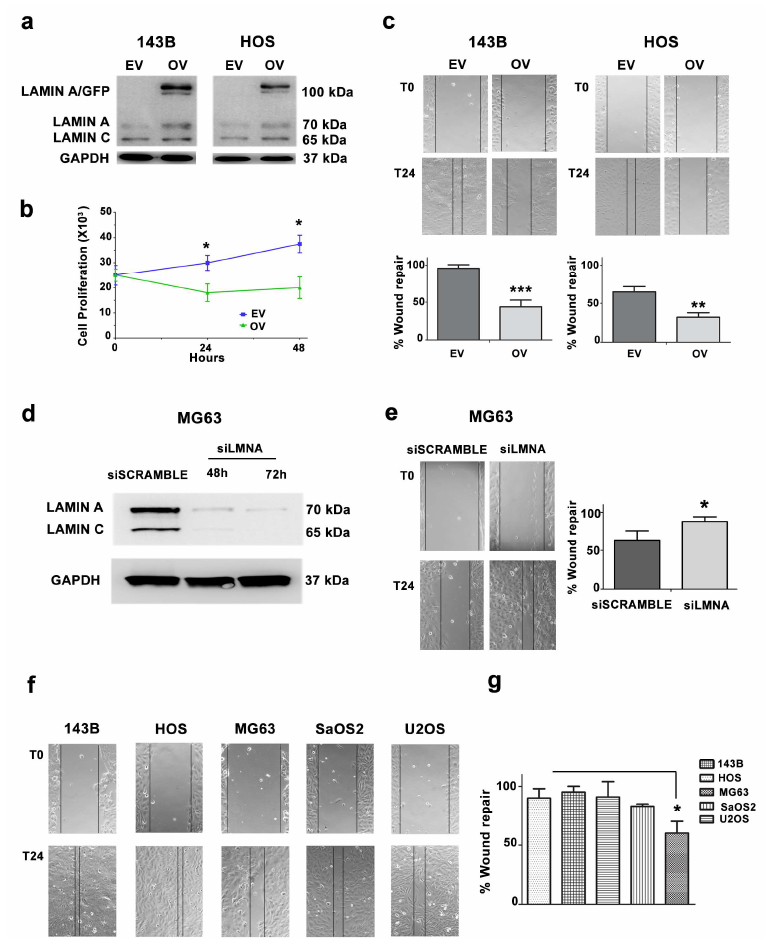
Figure 3. ( a ) Western blotting analysis of 143B and HOS cells transfected with GFP and lamin